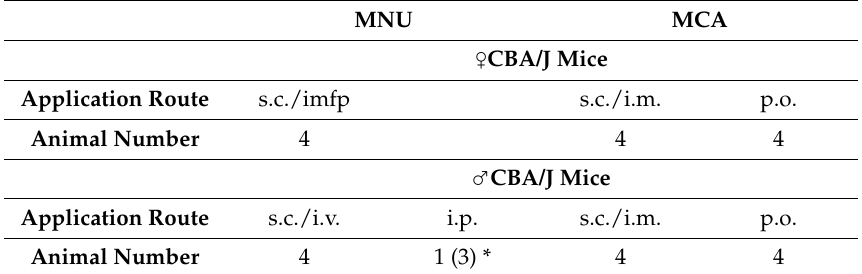
Table 1. Carcinogen application schedules for the induction of carcinogen-induced mouse-derived isograft (cMDI)